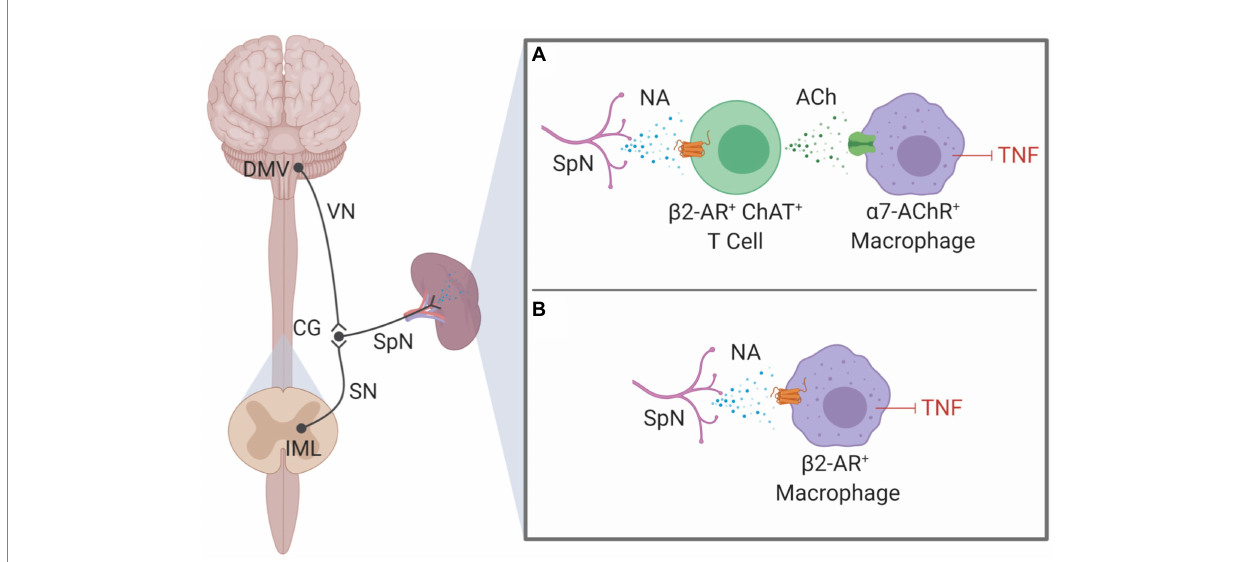
FIGURE 6 Cholinergic anti-inflammatory pathway revisited. The efferent arm of the inflammatory reflex, is composed of the vagus and the splanchnic nerve (SN) originating from the dorsal motor nucleus (DMV) and the intermediolateral nucleus (IML) respectively. Both nerve converge to the coeliac ganglion (CG) where they release acetylcholine (ACh) that binds to the α 7 subunit of the nicotinic acetylcholine receptor ( α 7-AChR) relaying the neural information to the adrenergic splenic nerve (SpN). (A) In the previously described CAP (Gallowitsch-Puerta and Pavlov, 2007; Jonge and Ulloa, 2009; Andersson and Tracey, 2012; Olofsson et al., 2012), the noradrenaline (NA) release at the splenic nerve termini, which binds to β 2-adrenergic receptor ( β 2-AR) of CD4+ T-cells, which in turn triggers the release of ACh. Engagement of the α 7-AChR at the surface of macrophage by locally produced ACh inhibits their production of TNF following LPS exposition. (B) Our data support a simpler model where, NA binds directly to β 2-AR to inhibit LPS-induced TNF